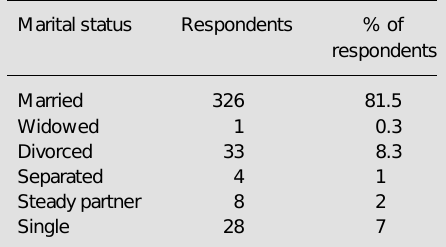
Table 3 - Marital status of the drivers